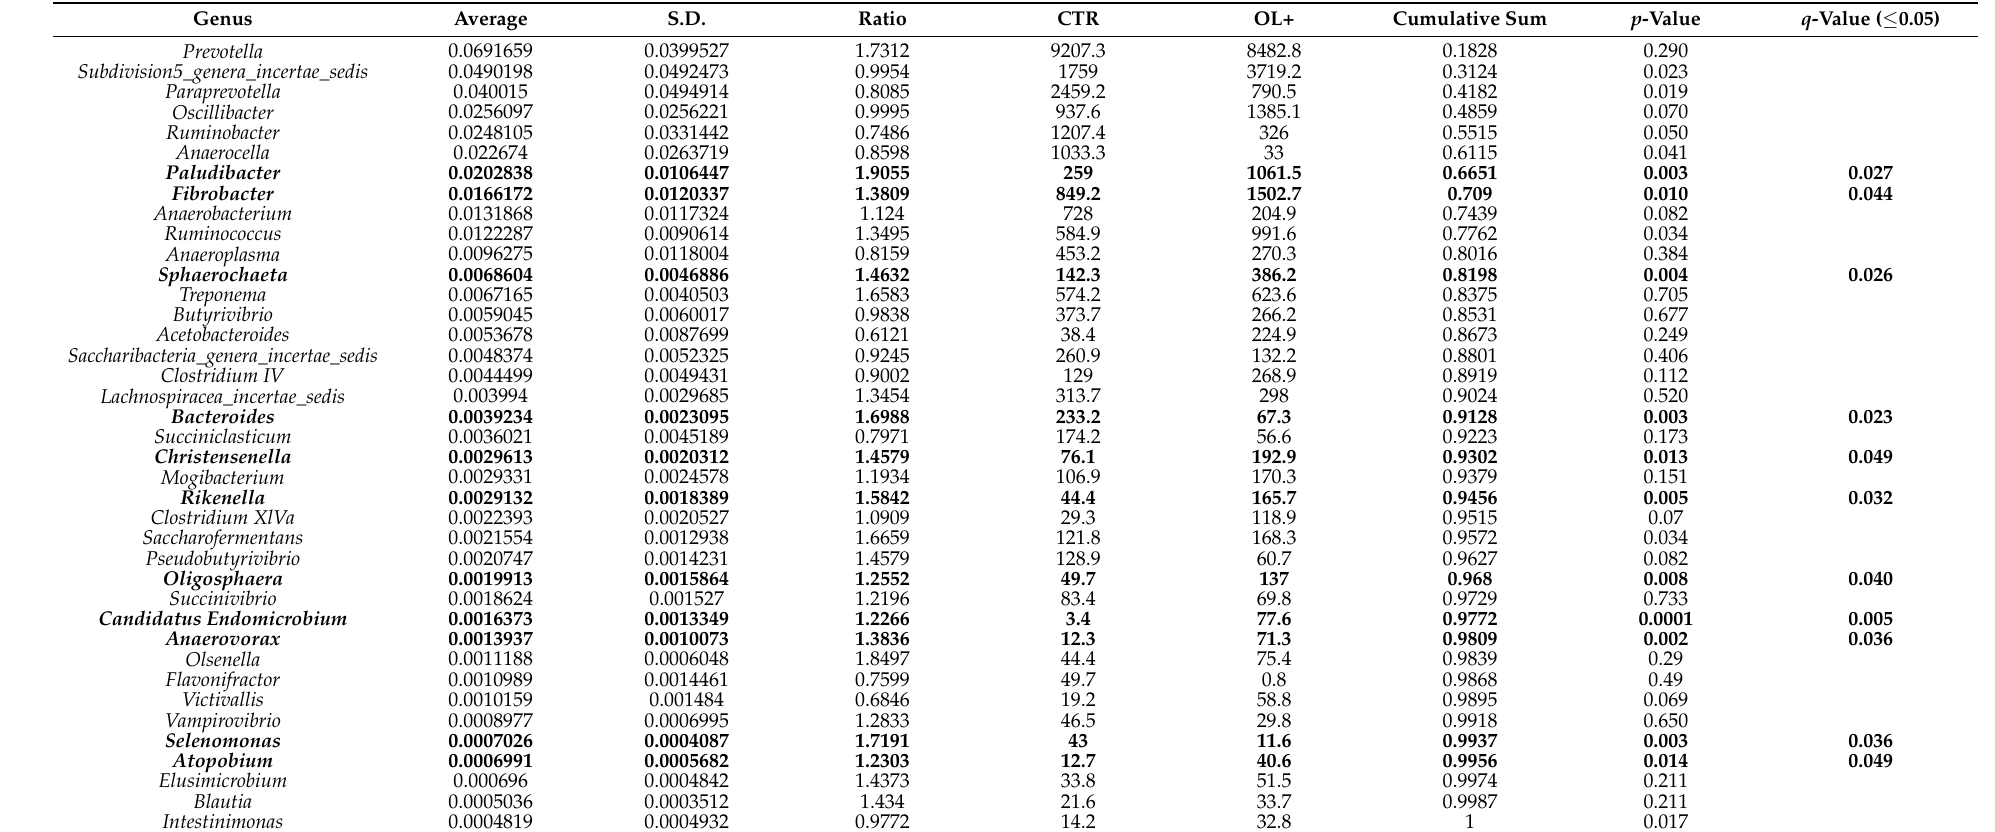
Table 3. SIMPER-generated genus list ordered by percentage contribution to Bray-Curtis dissimilarity and genera of which abundances significantly differ (OL+ vs CTR) based on Kruskal–Wallis